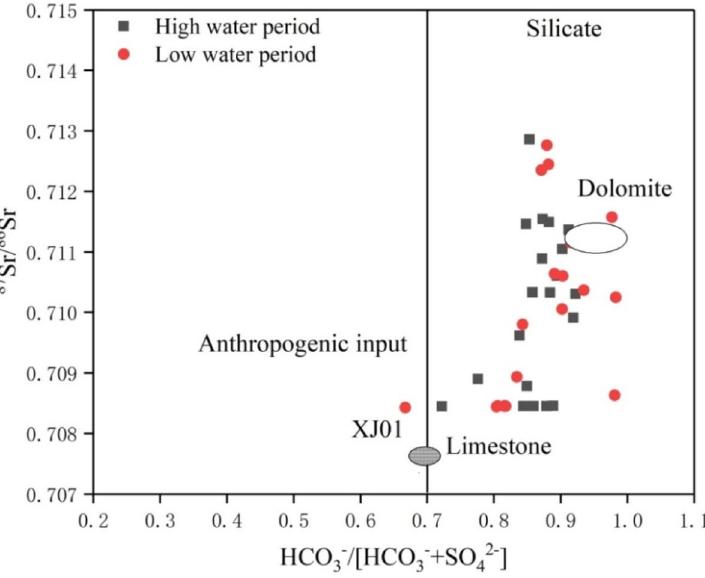
Figure 5. The relationship between 87 Sr/ 86 Sr and HCO 3 − /[HCO 3 − + SO 4 2− ] in river water during the high (grey squares) and low (red circles) water periods.